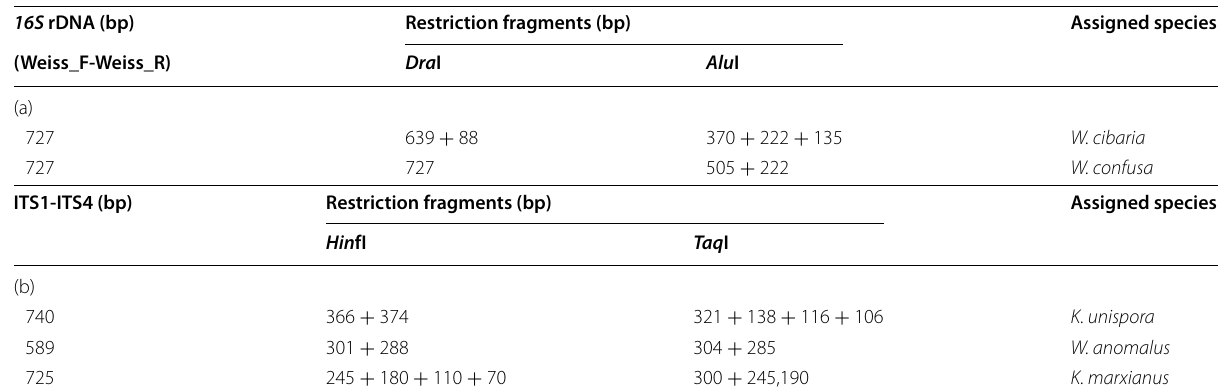
Table 3 Restriction patterns obtained for differentiation of Weissella sp. (a) and yeasts (b) isolated from maize bran fer-